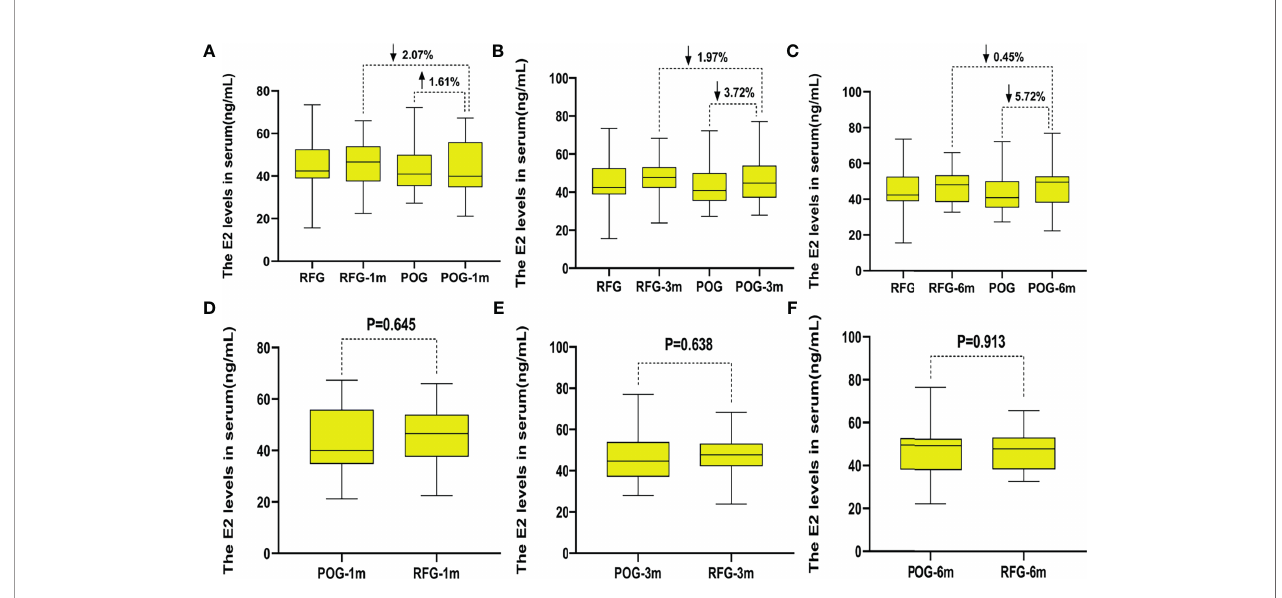
FIGURE 5 | The changes of estradiol (E2) levels in the two groups. Compared with preoperative, the increased rate of E2 levels in postoperative observation group (POG) after the fi rst postoperative month was 1.61%. Compared with E2 levels of referent group (RFG), the decline rate of E2 levels in POG after the fi rst postoperative month was 2.07% (A) . Compared with preoperative, the decline rate of E2 levels in POG after third postoperative month was 3.72%. Compared with E2 levels of RFG, the decline rate of E2 levels in POG after the third postoperative month was 1.97% (B) . Compared with preoperative, the decline rate of E2 levels in POG after the sixth postoperative month was 5.72%. Compared with E2 levels of RFG, the decline rate of anti-Müllerian hormone (AMH) levels in POG after the third postoperative month was 0.45% (C) . The E2 levels showed no signi fi cant difference in POG in the fi rst, third, and sixth month compared with RFG (p = 0.645, p = 0.638, p = 0.913, respectively) (D – F)